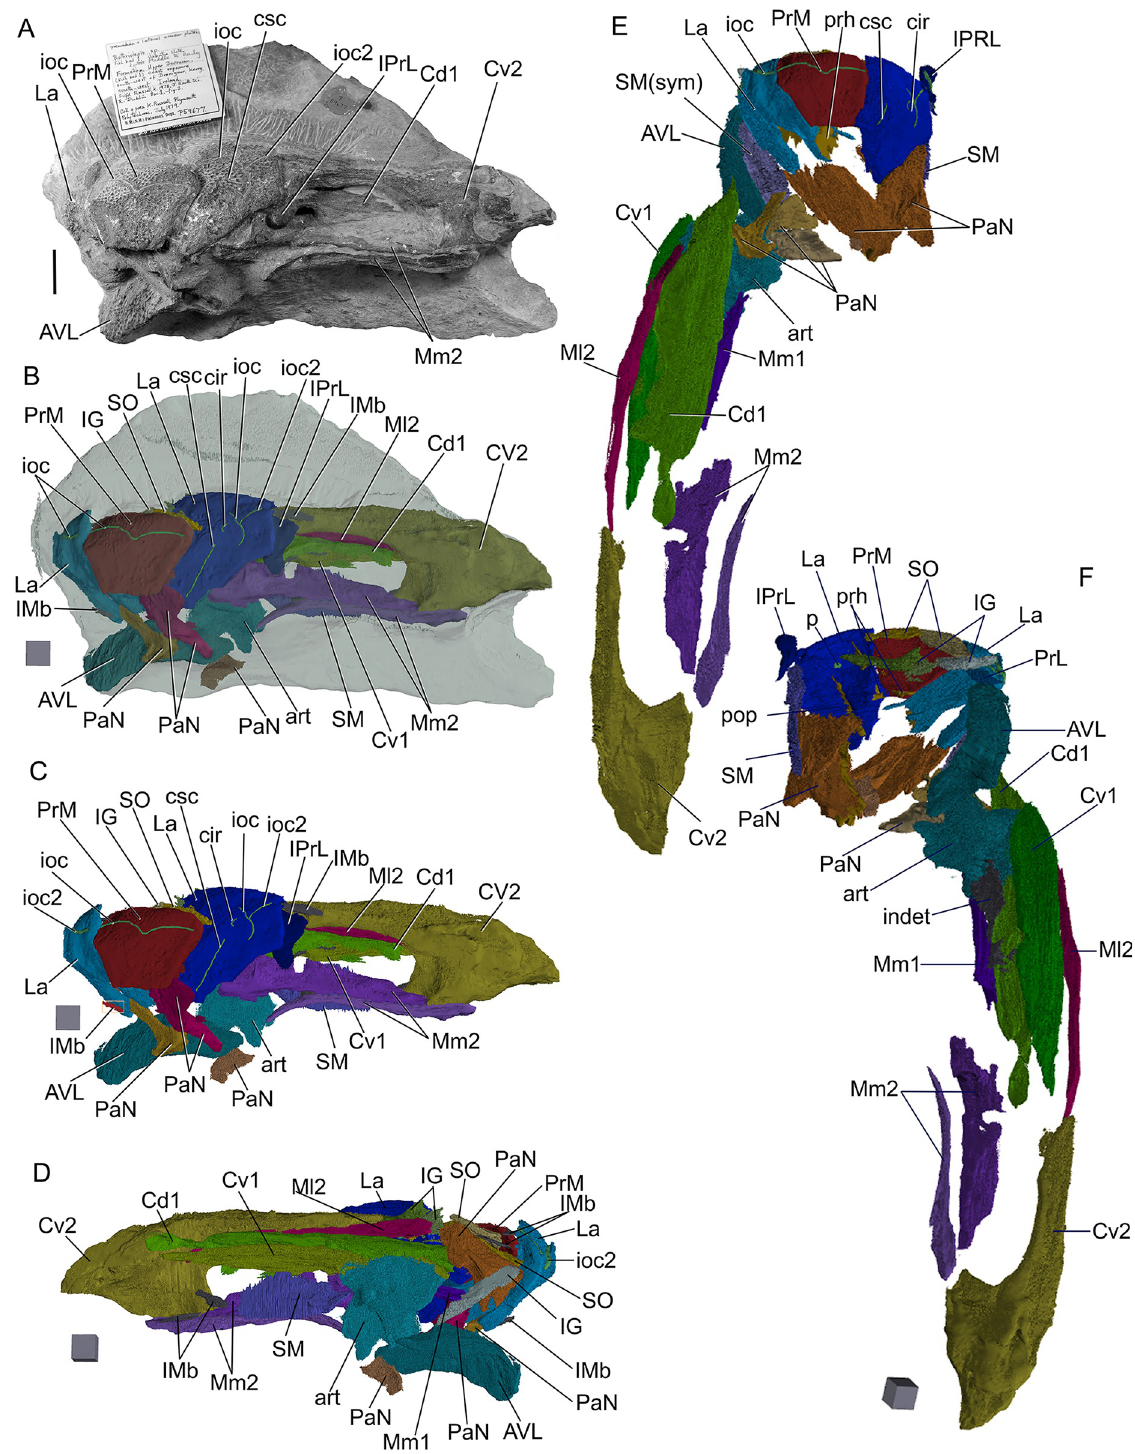
Fig 11. Bothriolepis dairbhrensis sp. nov. NHMP 59677. A. Photograph of specimen. B. Digital specimen with matrix rendered semi- transparent. C-D. Fossil bone material visible in the specimen with matrix rendered transparent (C in frontal view; D in opposite view). E-F. Reconstruction of plates in life position (as much as possible because of deformation) in dorsal (E) and ventral (F) views. Scale bar and edges of scale cube are 10mm.